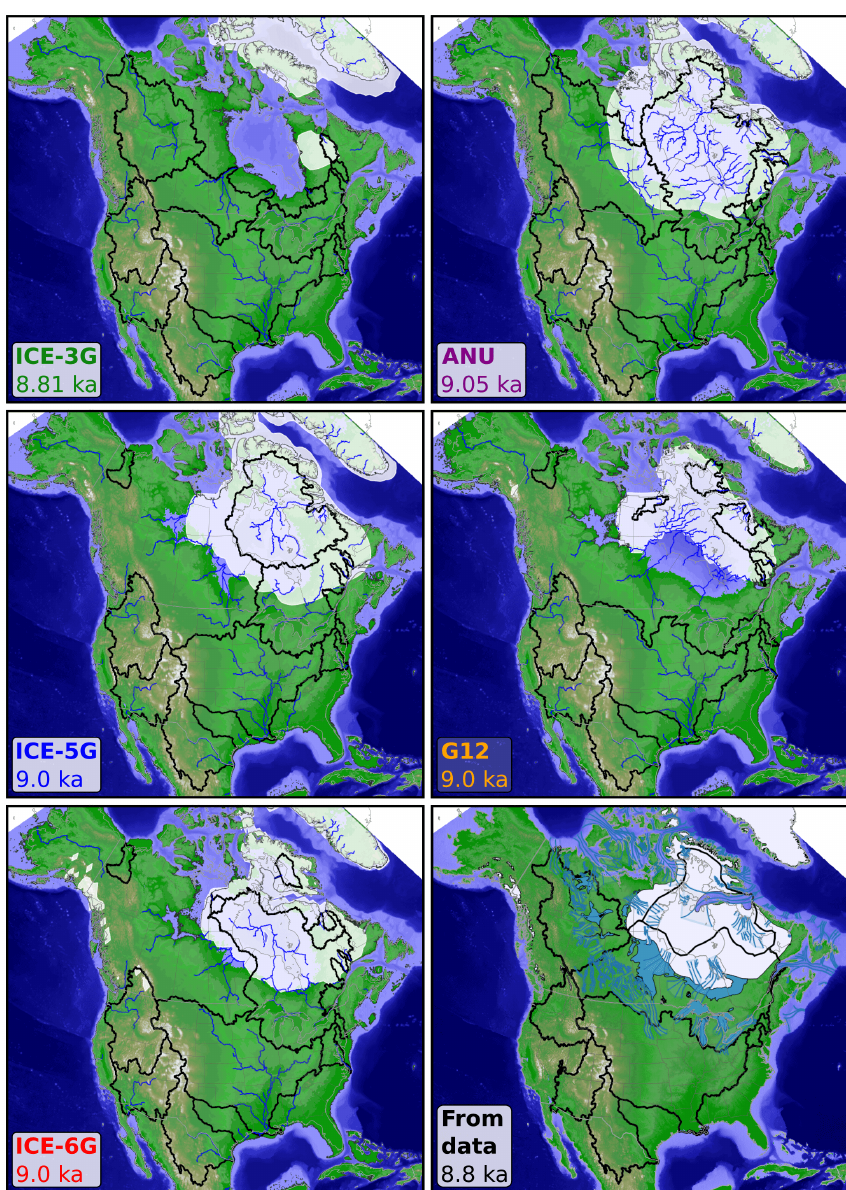
Figure 10. Early Holocene. The early Holocene was notable for its ice retreat and proglacial lake growth, which included enhanced flow down the Saint Lawrence River and abrupt drainage of proglacial lakes Agassiz and Ojibway into Hudson Bay. In G12, westerly flow around the ice dam in Hudson Bay could highlight a pathway for the 8.6ka partial drainage of Lake Agassiz–Ojibway (Breckenridge et al., 2012). Many other rivers no longer had ice-sheet input. In ICE-5G, the upper Missouri river occupies the preglacial Heart River valley in the Bismarck–Mandan area (Todd, 1914; Leonard, 1916; Bluemle, 2006) and flows into the James River, tributary to the Red River of the north, and away from the Mississippi (Sect. 5.1.3). This illustrates how sensitive low-gradient mid-continental river systems can be to subtle tilts of the land surface, especially when preexisting valleys and topographic slopes facilitate alternate flow paths.